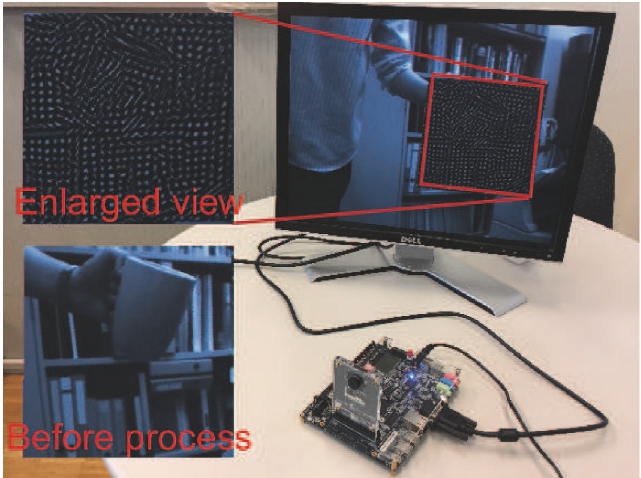
Figure 6: Real-time experimental setup. The processed window is superposed to the full VGA background. The unprocessed and processed window are enlarged in the